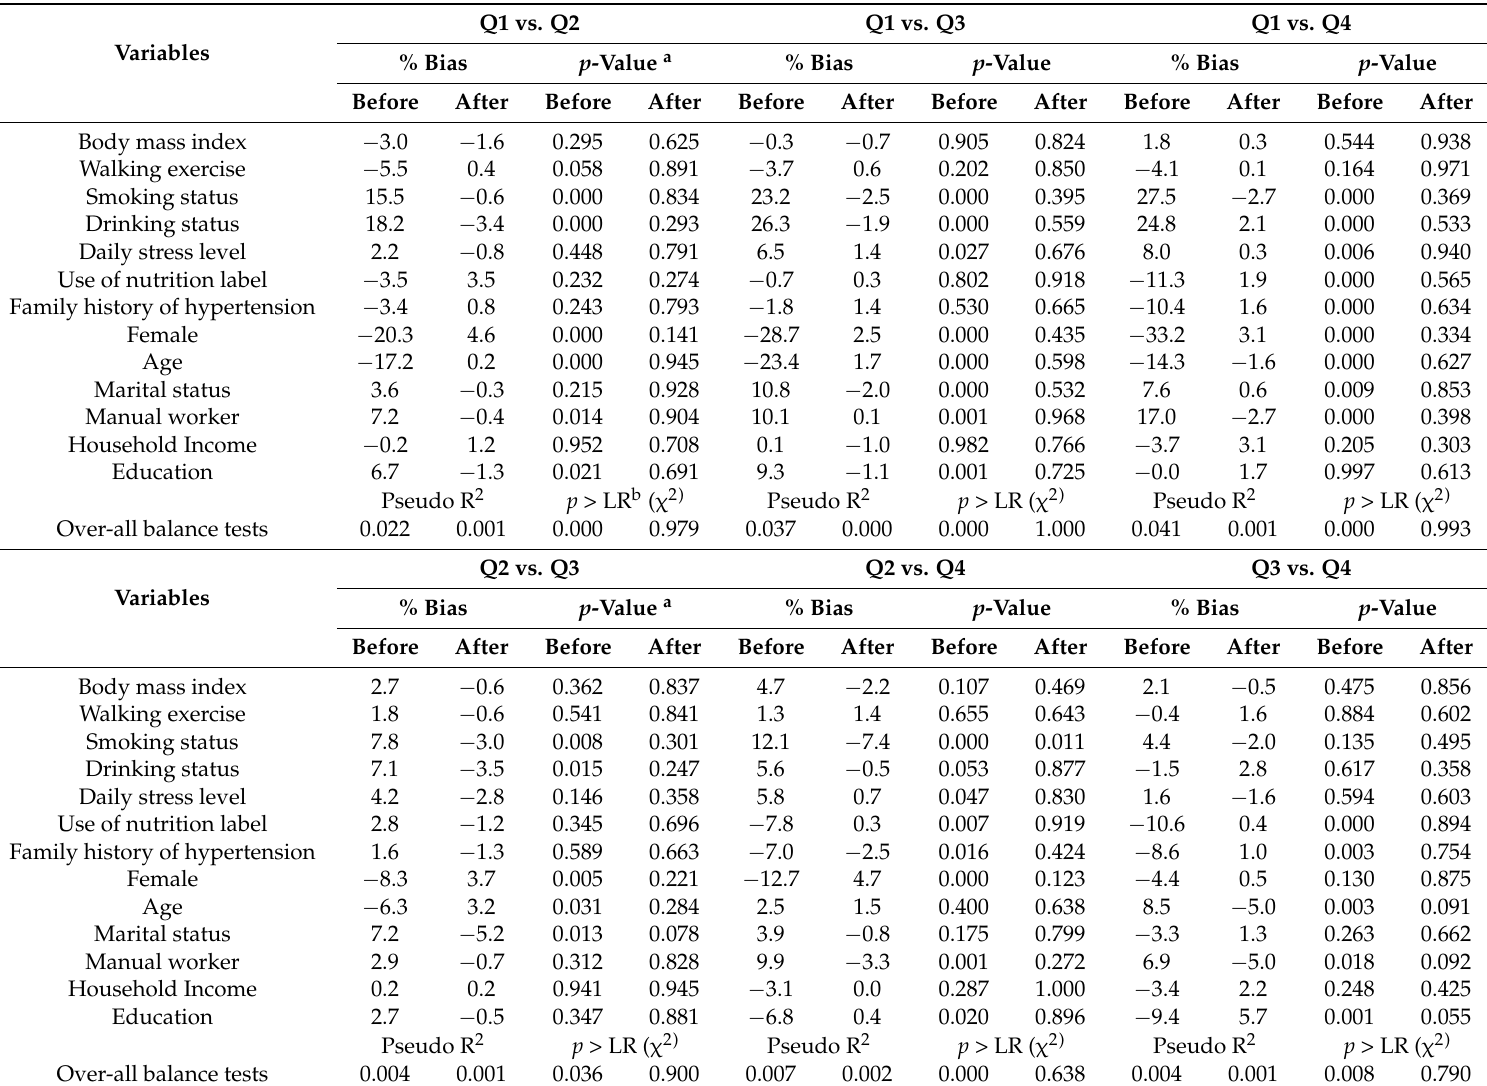
Table 4. Statistics for balance tests before and after propensity score